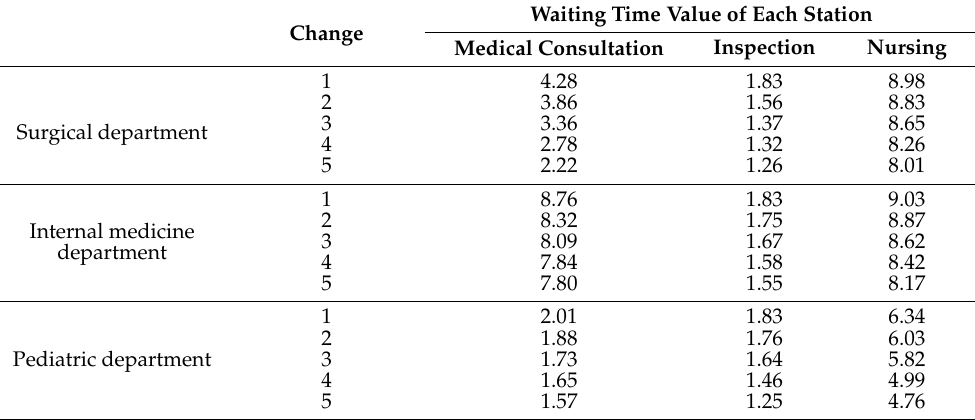
Table 1. Change in waiting times caused by each one-minute reduction in reported wait times. Waiting Time Value of Each Station Change Medical Consultation